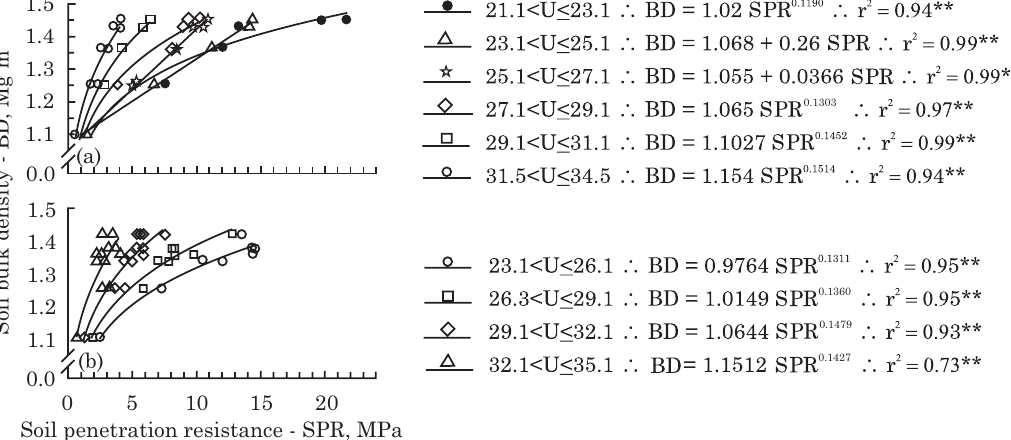
Figure 4. Pedotransfer functions to estimate soil bulk density in function of soil penetration resistance, for different ranges of gravimetric soil water content in the 5.5-10.5 cm layer (a) and 13.5-18.5 cm layer (b), in a Rhodic Eutrudox soil. **Statistically significant equations (F test, p<0.01).